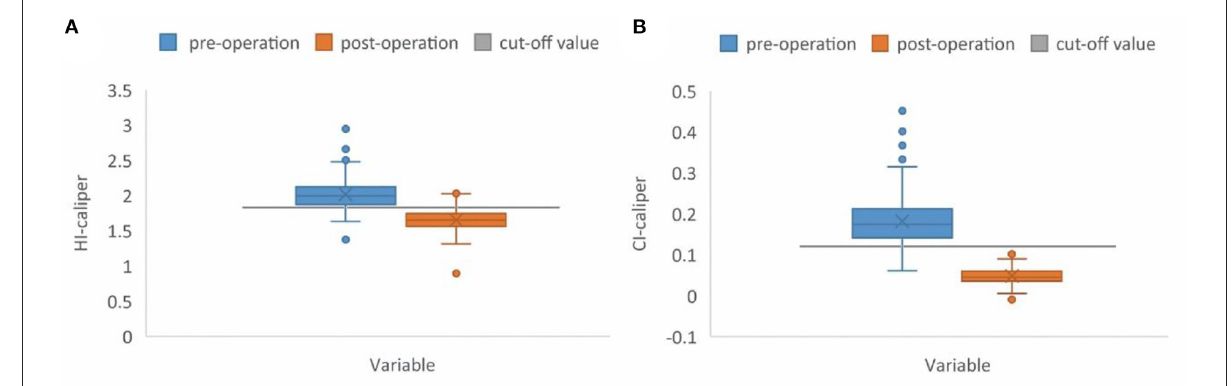
FIGURE5 Box plot. (A) The preoperative median HI-caliper was 1.99 (range: 1.37–2.94), vs. the post-operative value of 1.65 (range: 0.90–2.03). The post-operative HI-caliper, of 154 patients (87.5%), recovered and dropped below the cut-off value of 1.83. (B) The preoperative median CI-caliper was 17.43% (range: 6.12–45.12%), vs. the post-operative value of 4.49% (range: − 0.96–11.27%). The post-operative CI-caliper of all patients (100.0%) recovered and dropped below the cut-off value of